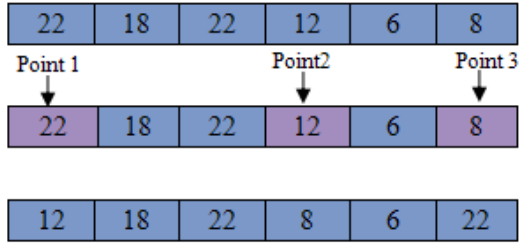
Figure 5. Local search